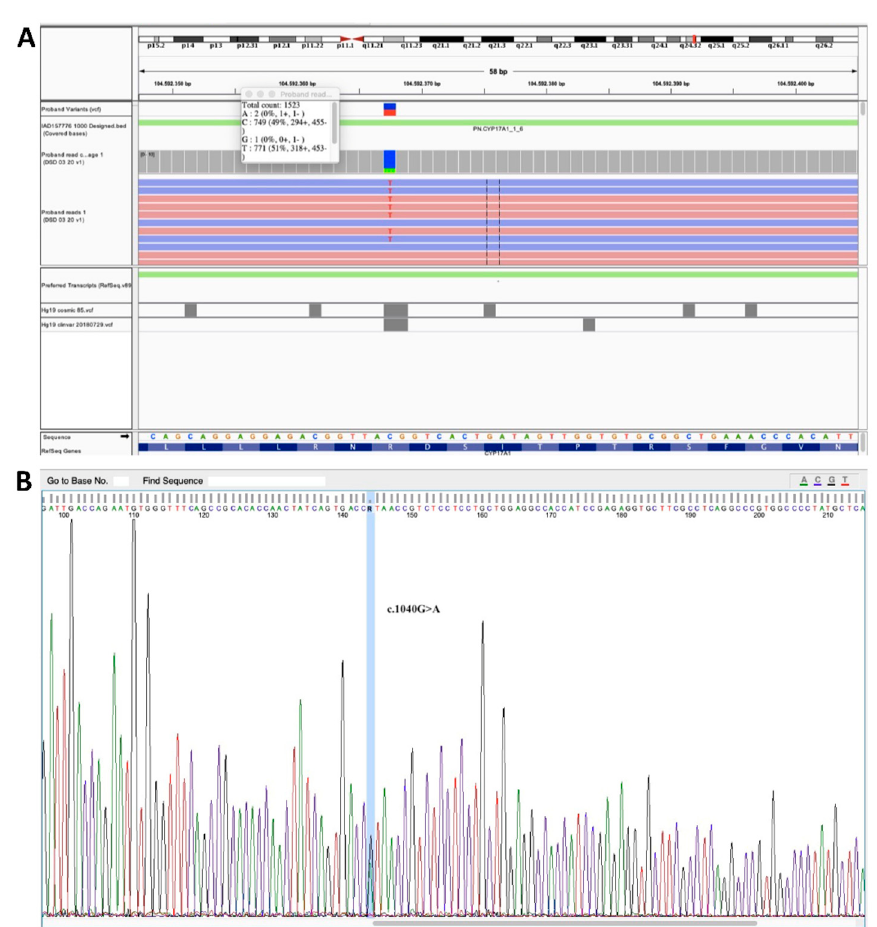
Figure 1. NGS analysis and Sanger sequencing of exon 6 of CYP17A1. ( A ) Heterozygous c.1040G > A (p.Arg347His) mutation in the CYP17A1 gene as highlighted by NGS analysis. ( B ) Sanger sequencing of exon 6 of CYP17A1.